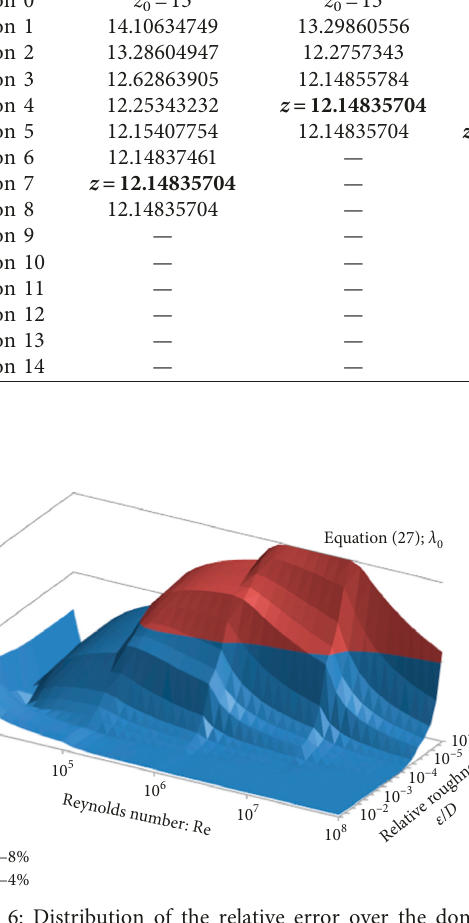
Re/2.18 using the Newton–Raphson, the Halley, and the Schr¨oder iterative methods. (cid:31) Re/2.18 2293411.45 Re Re 5 10 6 , y (cid:31) (cid:31) (cid:31) ·